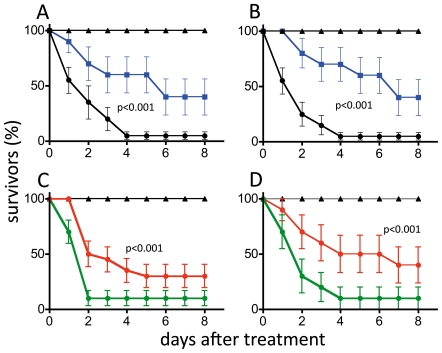
Survival rates of treated ants.Survival curves for workers (solid circles) and gamergates (solid squares) injected with live Erwinia carotovora (A, C) or with paraquat (B, D). The percentage of survivors is plotted against the time following injection (± S.E.M.). The control animals (triangles) were injected with the same volume of sterile LB-medium instead of bacterial suspension. Statistical analysis was performed with Cox regression analysis; p values are given in the figure. Survival curves for gamergates (solid squares - blue) and workers (solid circles - black) that were injected with the Erwinia carotovora (A) or the ROS generating compound paraquat (B). Workers isolated for 24 h prior to the experimental injections (solid circles - red), showed a statistically significant increased survival following injection of pathogens (matching controls; solid circles - green) (C) and paraquat (D). The number of animals per experimental group was n = 30. Mean values are given ± S.E.M., p-values are listed in the figures.